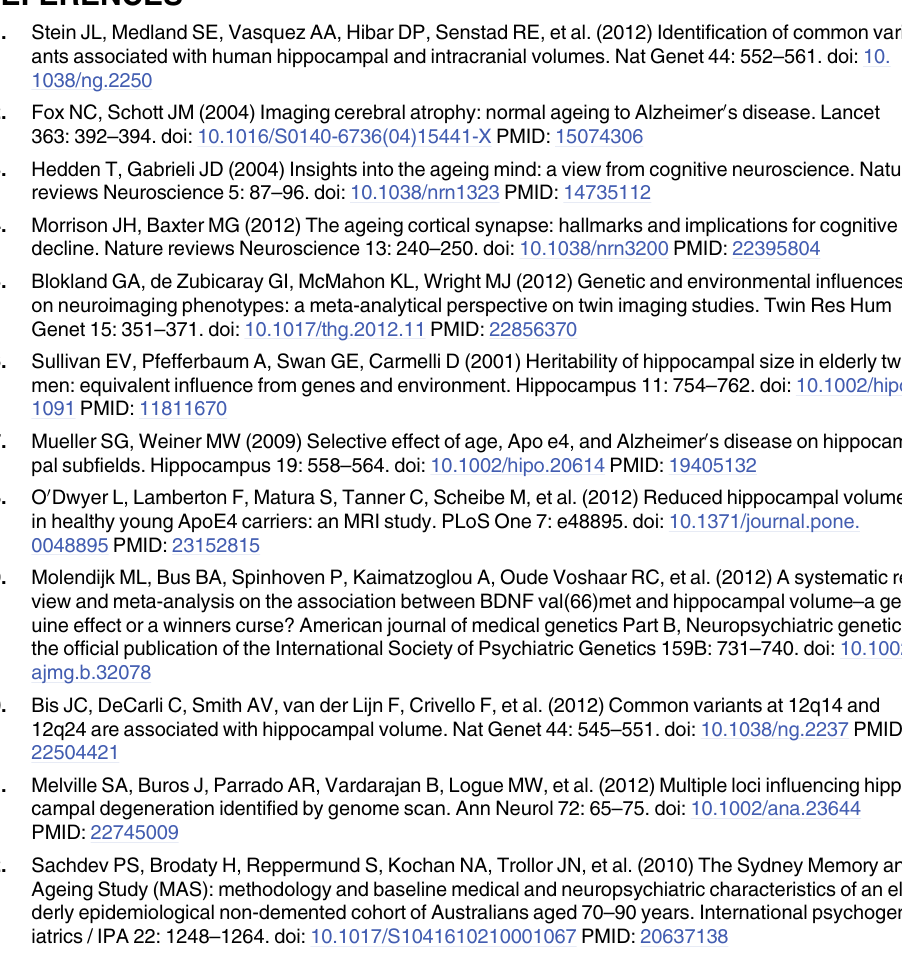
S2 Fig. Genome-wide Manhattan plot for hippocampal volume using the Older Australian Twins Cohort. P-values for each individual SNP are plotted against chromosome position from the results of the association analysis with bilateral hippocampal volume. The analysis was adjusted for age, sex, scanner and